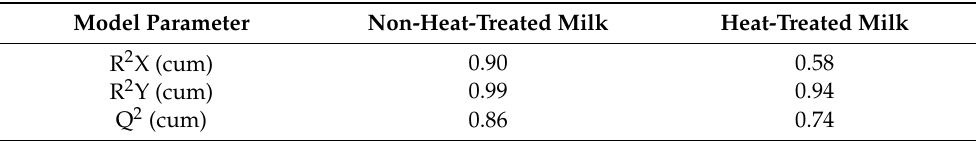
Figure 2. OPLS-DA score plots were generated by considering the metabolomic profile of the non-heat-treated ( A ) and heat-treated ( B ) milk samples. Abbreviations: T1CN = non-inoculated sample incubated for 24 h; T1PF = inoculated sample incubated for 24 h; T6CN = non-inoculated sample incubated for 144 h; T6PF = inoculated sample incubated for 144 h. Table 2. Goodness-of-fit parameters of the OPLS-DA models